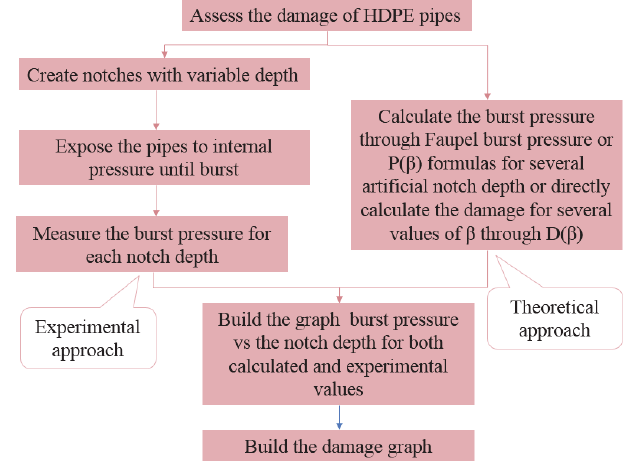
Figure 2: Damage building methodology.